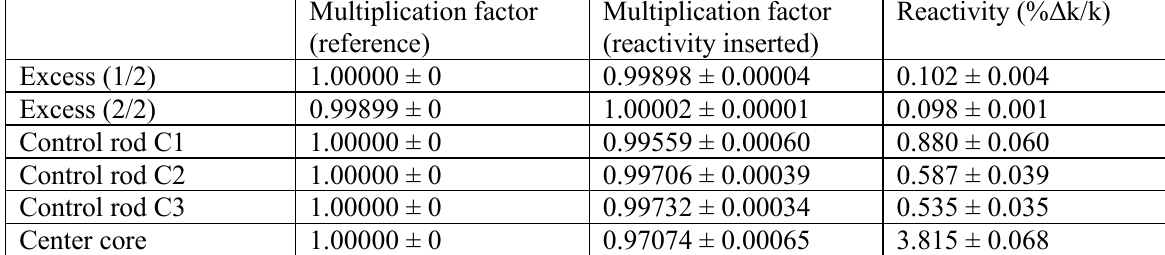
Table III. Measured multiplication factor and reactivity: Errors correspond to